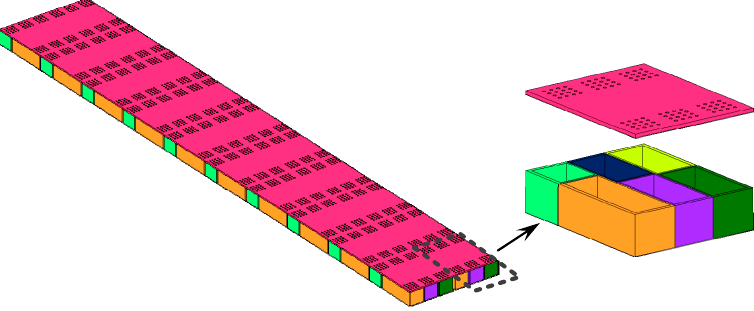
Figure 15. Planar non-uniform acoustic absorber formed by planar BAUs.